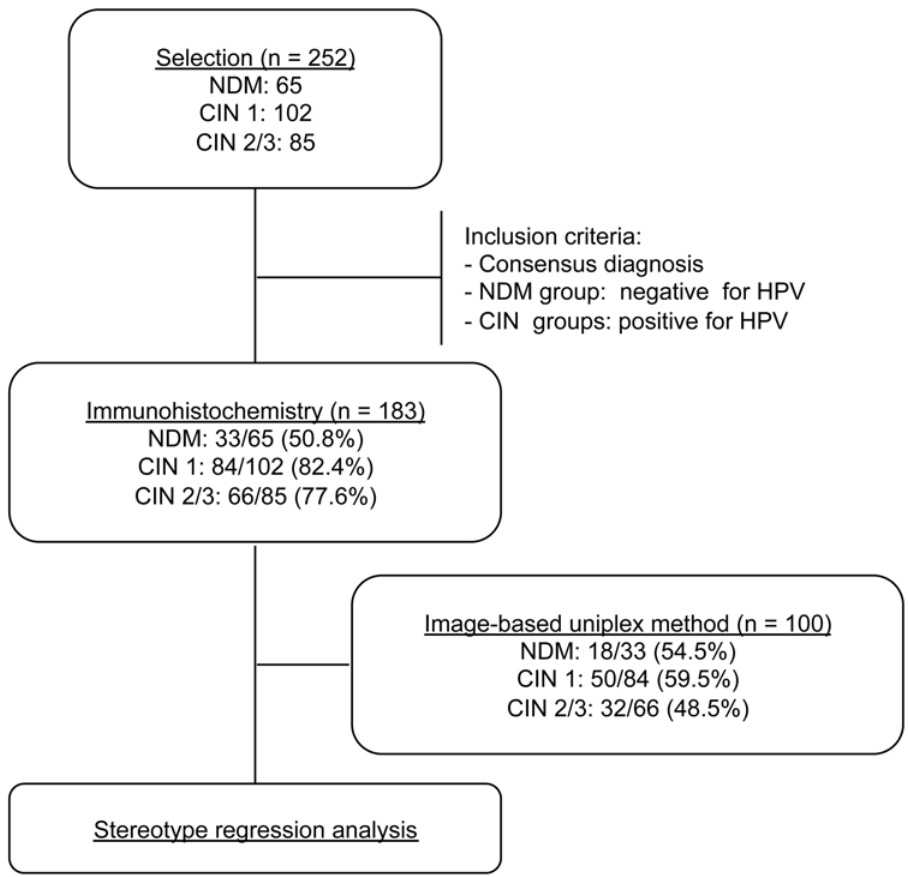
Fig 1. Study procedures and outcomes. The flow diagram shows the number of samples that were obtained from the laboratory file as well as those that were included in the immunohistochemistry and statistical